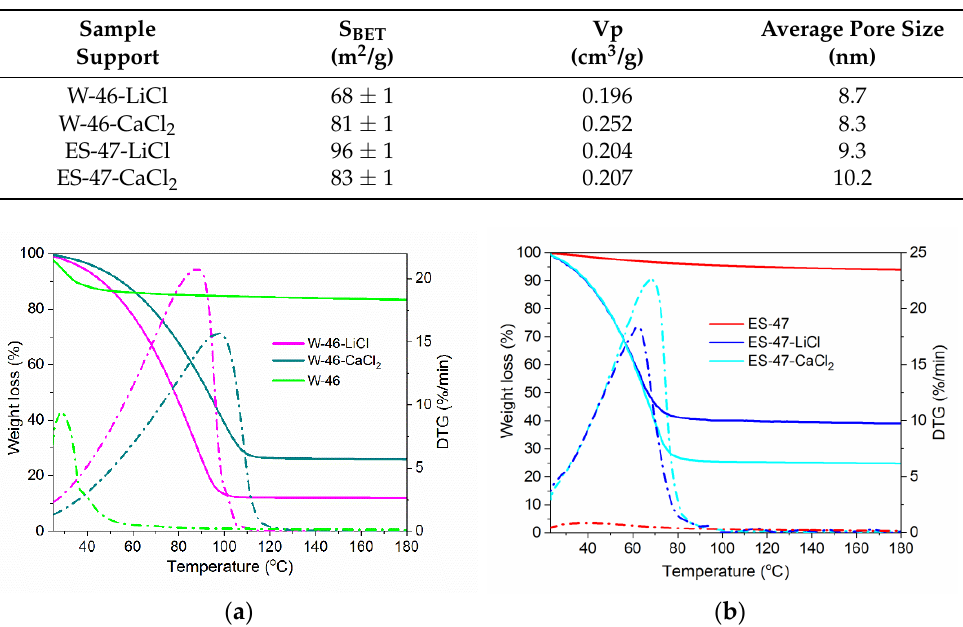
Table 2. Textural properties of the of the W-46 and ES-47 composites.